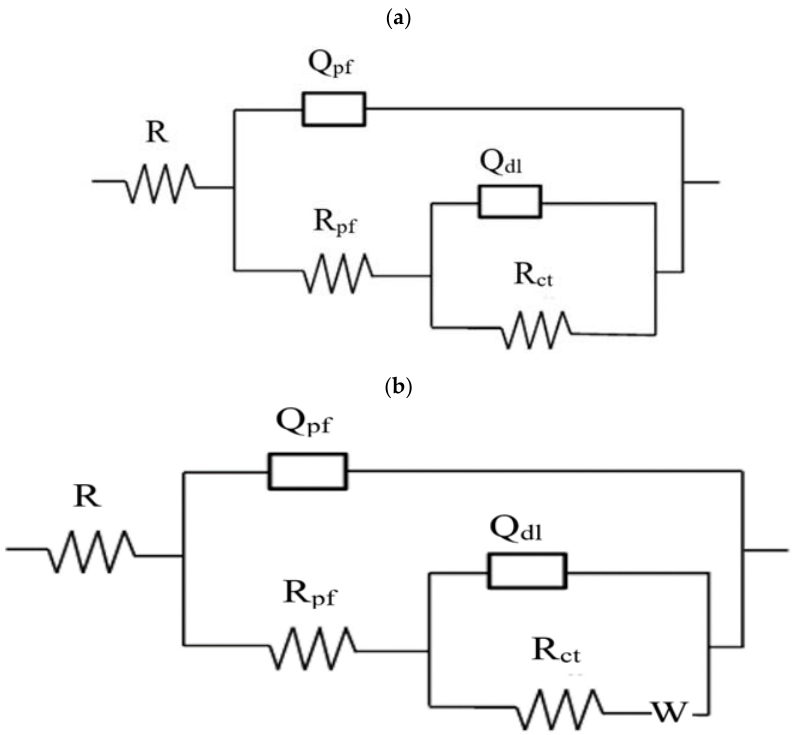
Figure A2. Equivalent electrical circuits that fit the impedance data for the steels pre-exposed to SWSSNC for various durations: ( a , b ) for mild steel, and ( b ) stainless steels.